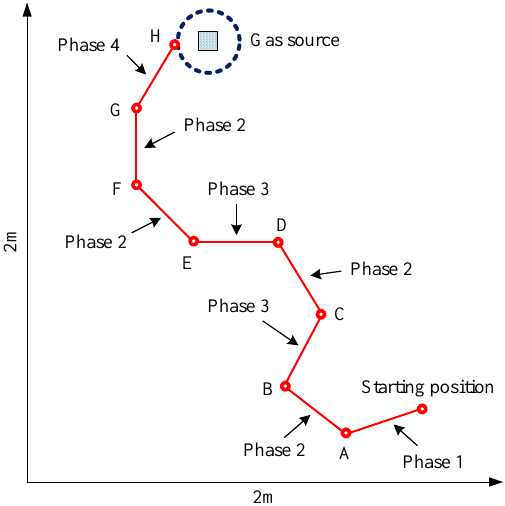
Figure 11. Typical trail of olfaction robot plume